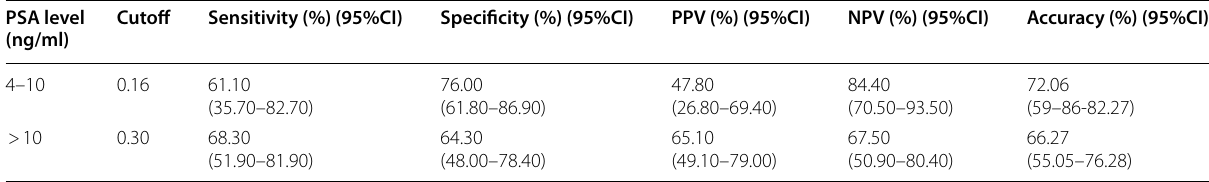
Table 4 Cutoff point for PSAD in the discrimination of prostate cancer among patients with PSA levels 4–10 and > 10 ng/ml PSA level